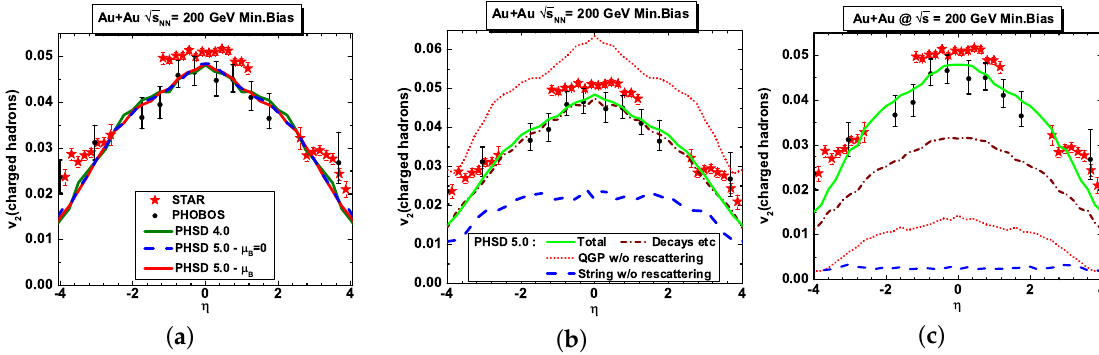
Figure 6. Plot ( a ): elliptic flow of charged hadrons as function of pseudo-rapidity η for minimum bias √ s NN =200 GeV for PHSD4.0 (green lines), PHSD5.0 with partonic cross sections Au+Au collisions at and parton masses calculated for µ B = 0 (blue dashed lines), and with the actual µ B (red lines) in comparison to the experimental data from STAR [42] (solid starts) and PHOBOS [43] (solid dots). Plot ( b ): individual contributions to v 2 without their relative weights to the total v 2 , which are indicated by a green solid line for PHSD5.0 with µ B : the red dotted line corresponds to the final hadrons coming from the QGP without rescattering in the hadronic phase, the blue dashed line indicates the v 2 of hadrons coming from strings while the brown dot-dashed line shows the v 2 of hadrons coming from mesonic and baryonic resonance decays. Plot ( c ): individual contributions to v 2 including their relative weights to the total v 2 .